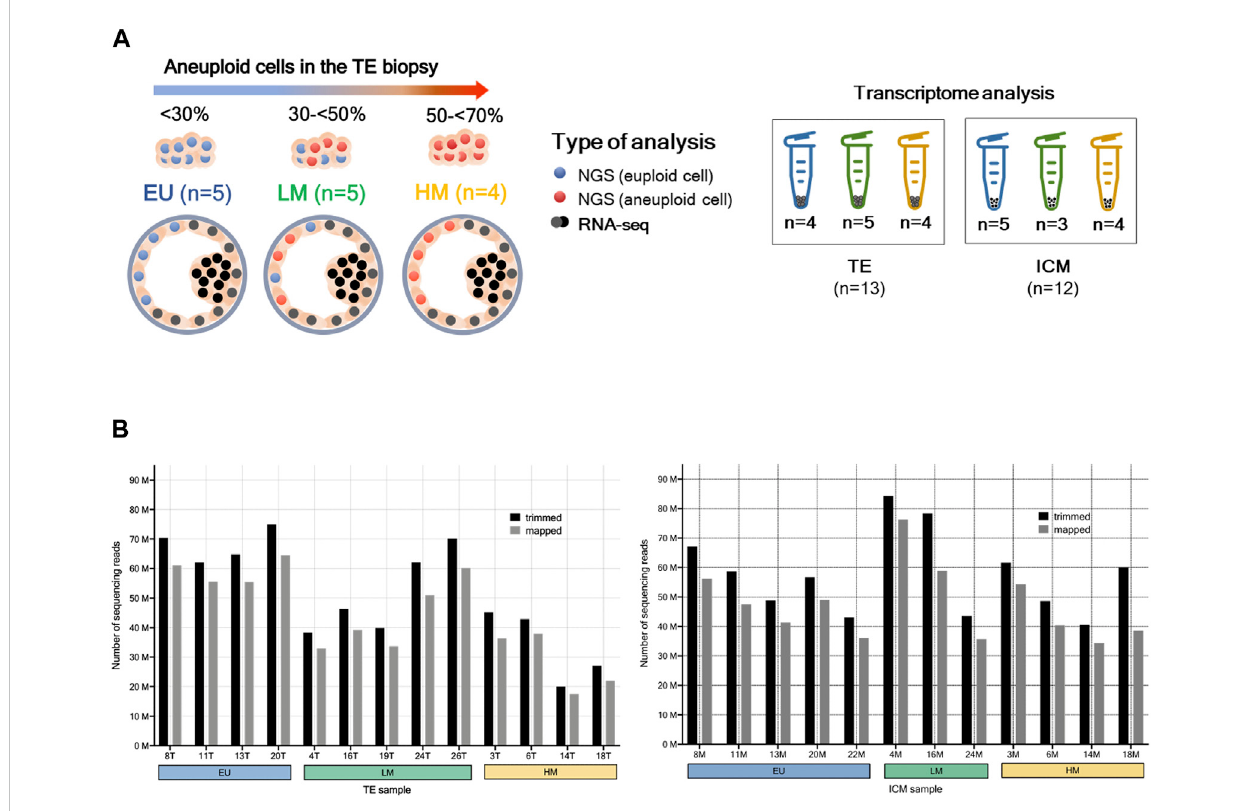
FIGURE 1 RNA-sequencing. (A) Study design. A single trophectoderm (TE) biopsy was analysed by next-generation sequencing (NGS). Blastocysts were classi fi ed as i) euploid (EU): < 30% aneuploid cells, ii) low-level mosaic (LM): 30%- < 50% aneuploid cells, and iii) high-level mosaic (HM): 50% – < 70% aneuploid cells. The remaining TE (grey cells) and the inner cell mass (ICM) (black cells) were separately collected from each blastocyst and analysed by RNA sequencing (RNA-seq). (B) Transcriptome sequencing reads of TE and ICM samples. Trimmed reads were obtained through the elimination of adapter sequences and the removal of poor-quality bases from input reads. Mapped reads were aligned to the reference genome.